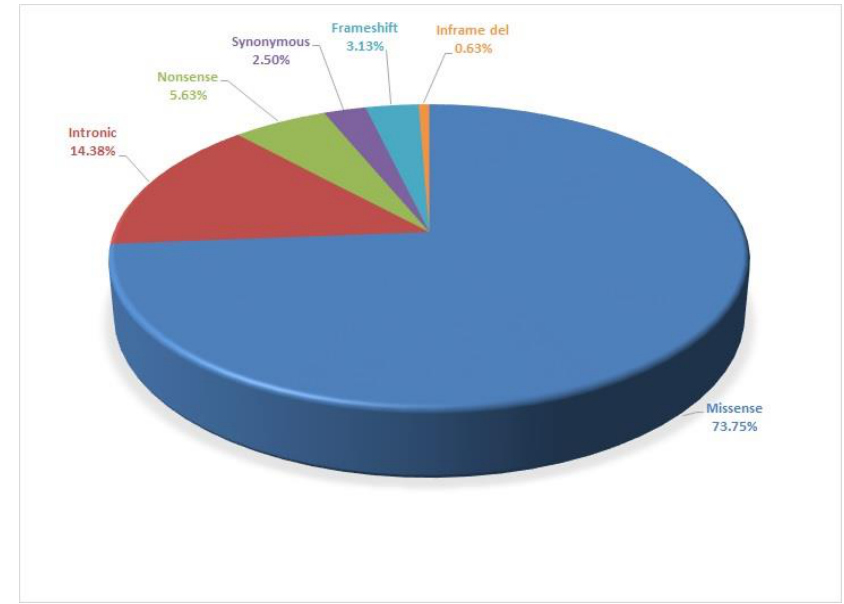
Figure 3. Description of the detected types of mutations. Deletion–duplication of CFTR was investigated with the MLPA method in 391 patients with no mutations, and deletion was detected in 3 patients. Two of three patients had exon 10 deletions, and the others had multiple exon (exon 4–11) deletion—these patients had no mutations detected by sequencing (MLPA results are not shown in tables and